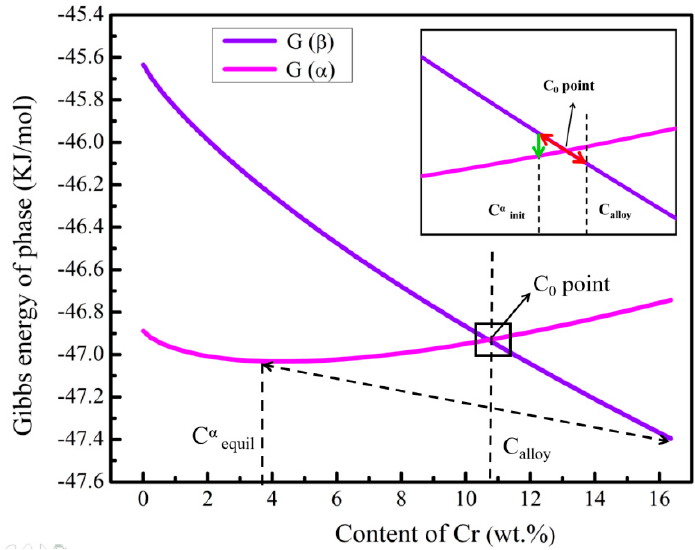
Figure 11. Calculated Gibbs energy curves of α and β phases in Ti ‐ 6Al ‐ 10.9Cr alloy, at 600 °C.